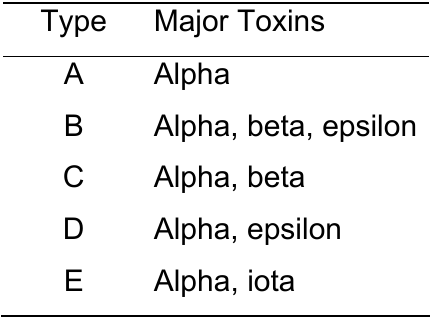
Table 1: Classification of C. perfringens into types based on the major toxins produced